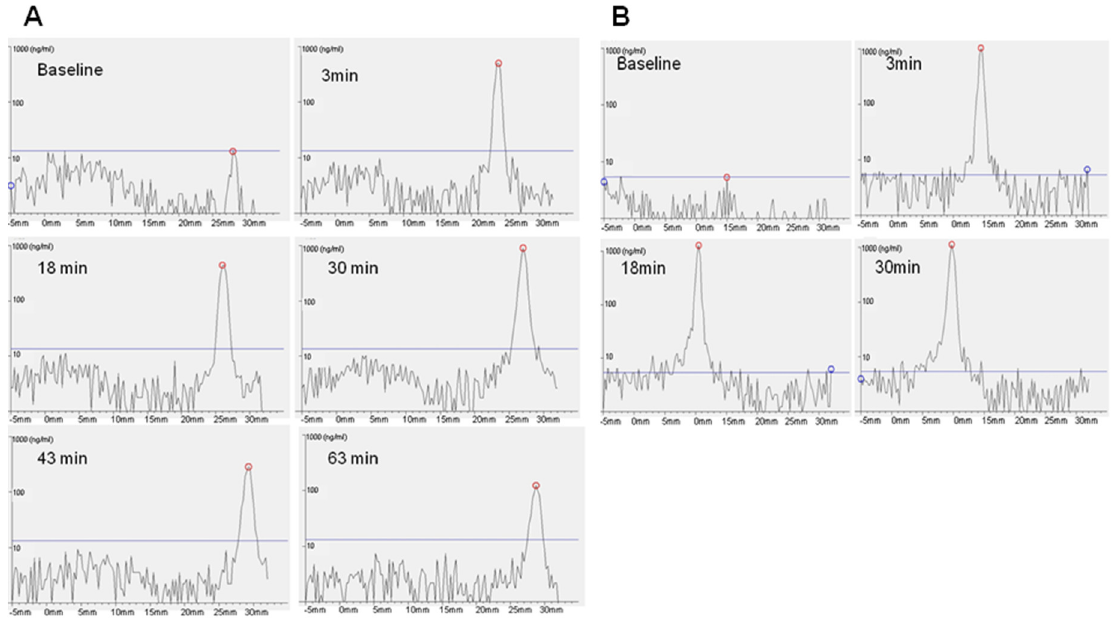
Figure 6. Fluorotron master scan of fluorescein-tagged liposomes migration from ( A ) viscous formulation and ( B ) gel formulation within the eyes of anesthetized Sprague-Dawley rats. Two eyes of one rat were used for each formulation.